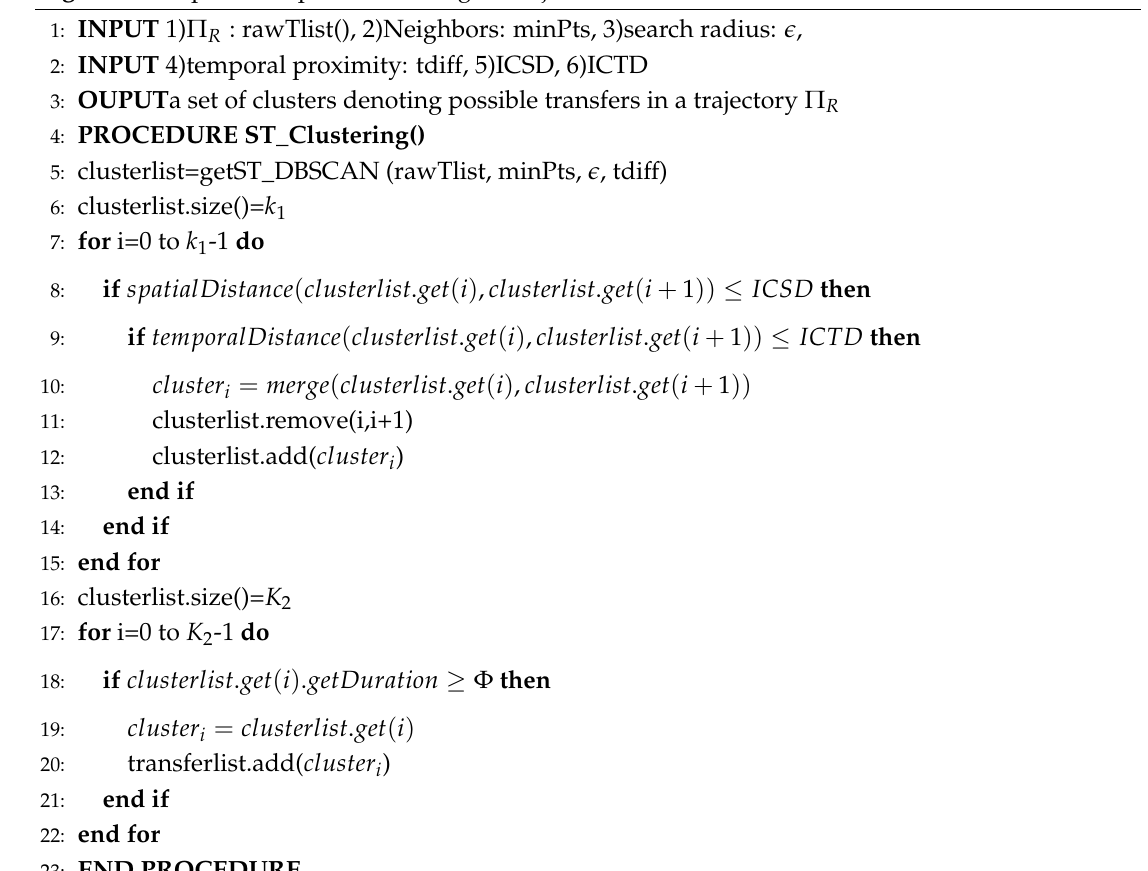
Algorithm 3 Spatio-temporal clustering on